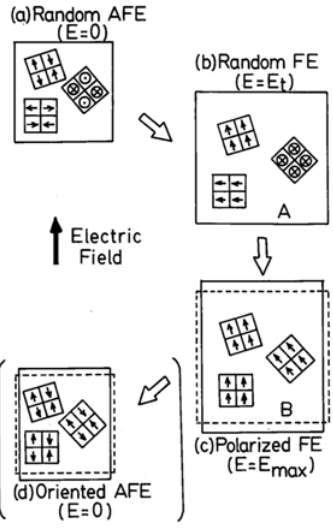
Figure 13. Schematic illustration of the antiferroelectric domain reorientation associated with the forced phase transition.